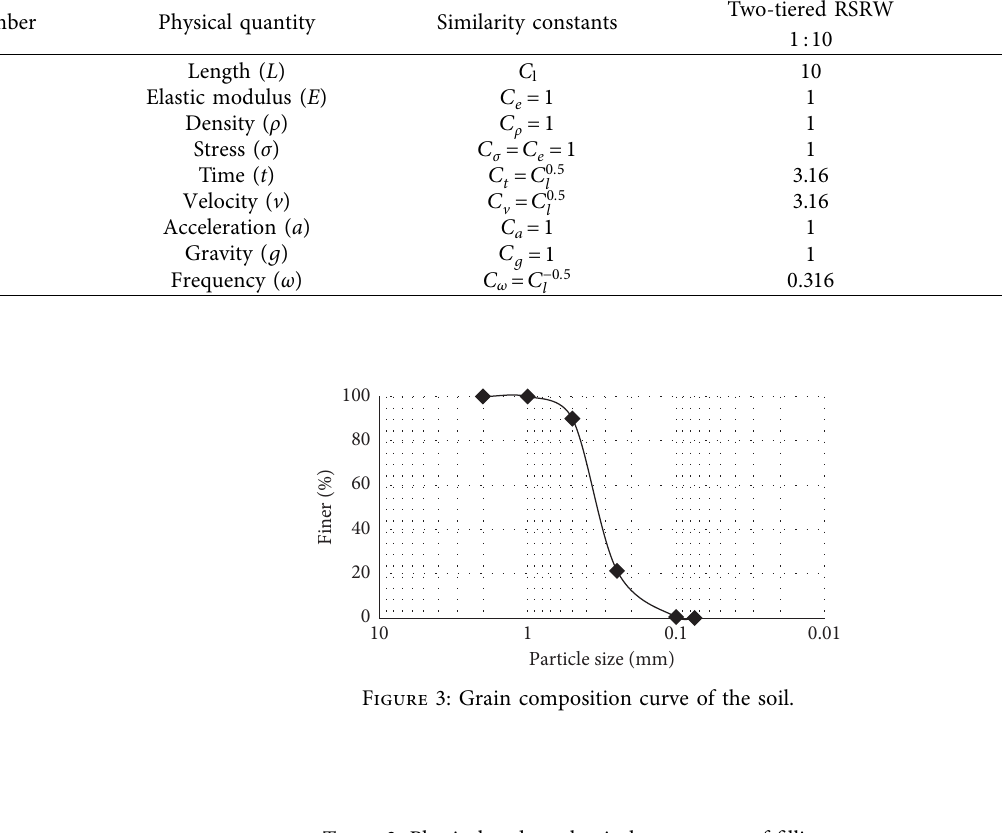
Table 2: Physical and mechanical parameters of filling.